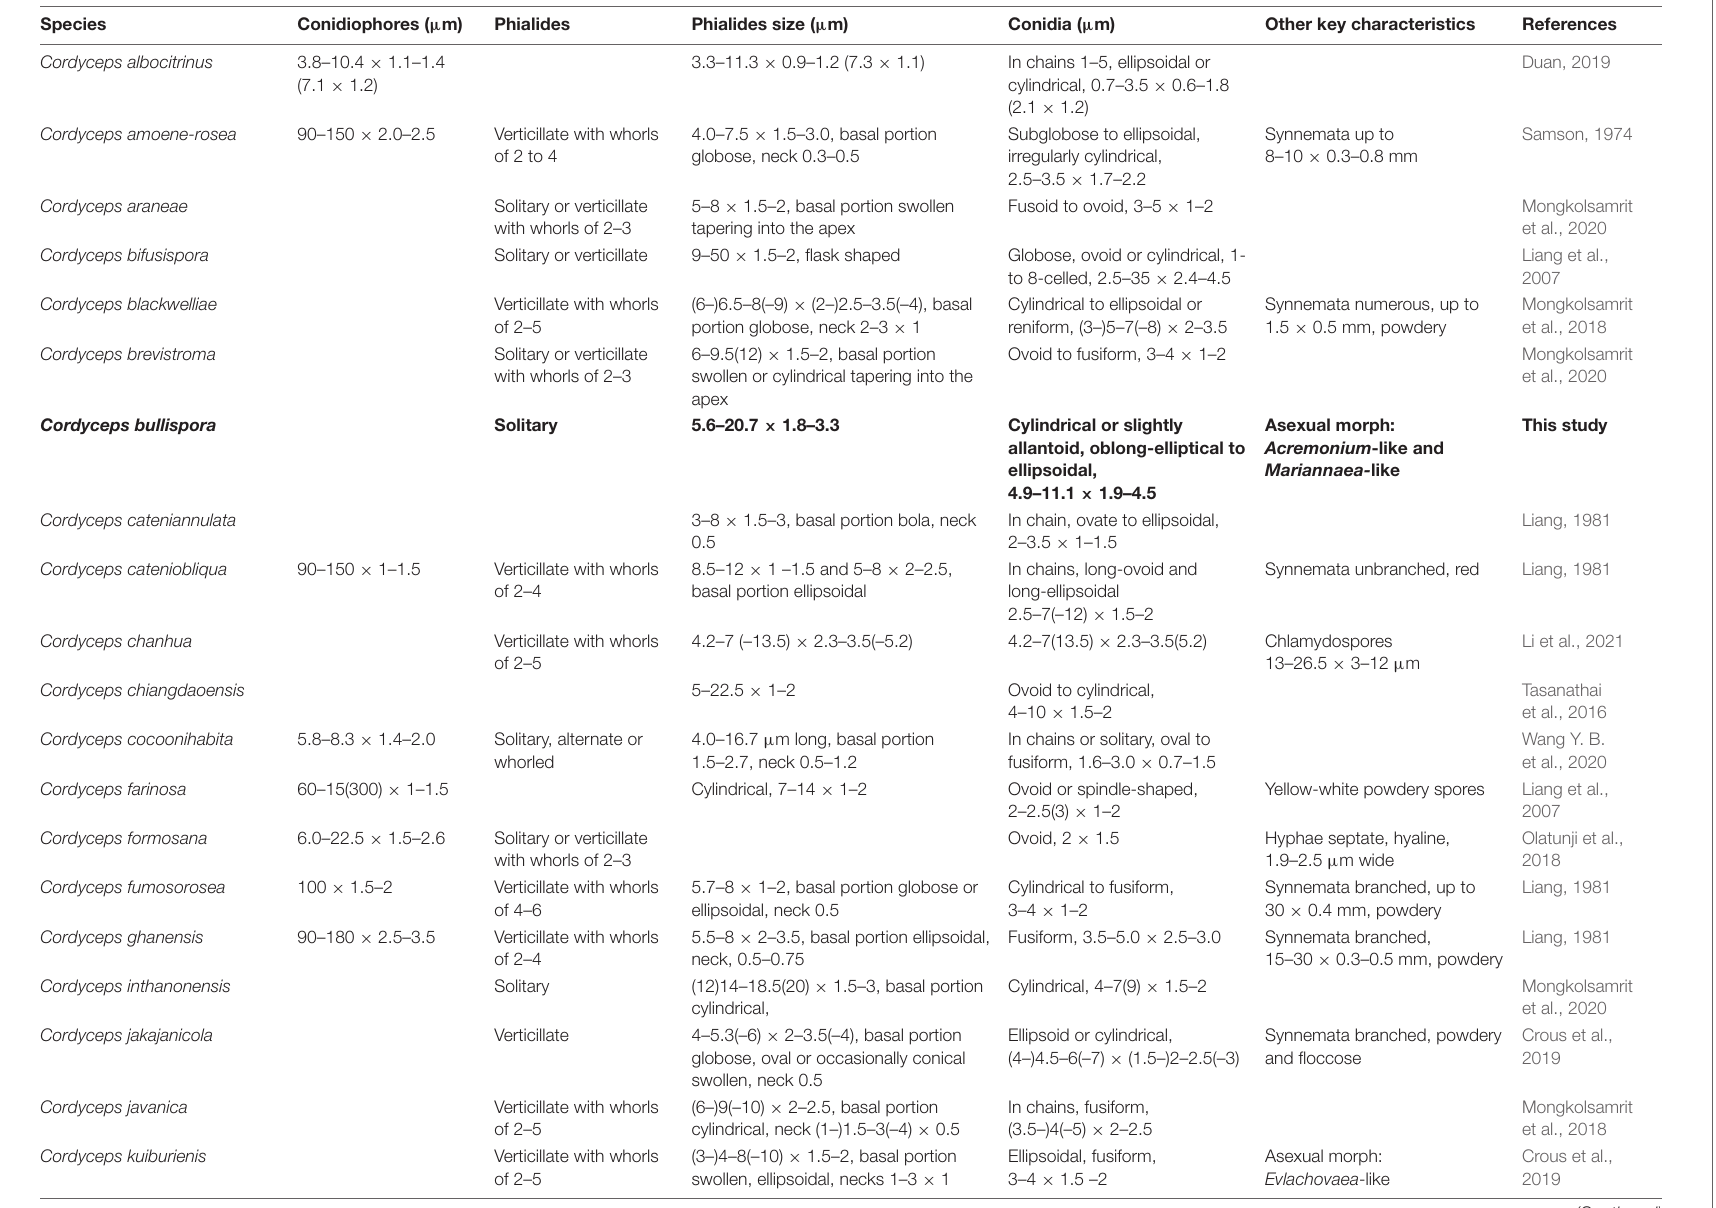
TABLE 3 | Comparison between the asexual morphs in